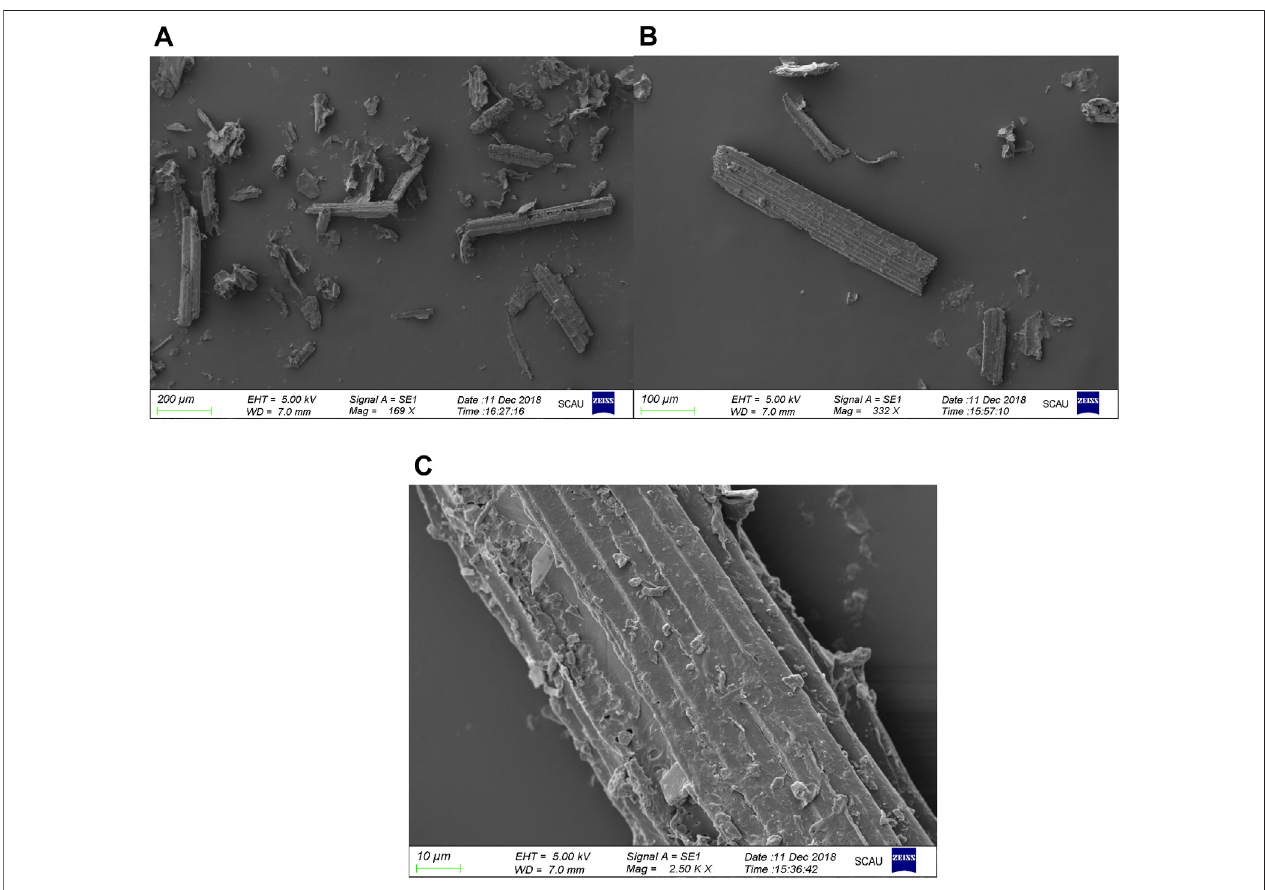
FIGURE 3 | SEM images of the Pennisetum hydridum fi ber at different scales: (A) 200 µm; (B) 100 µm; (C) 10 µm.